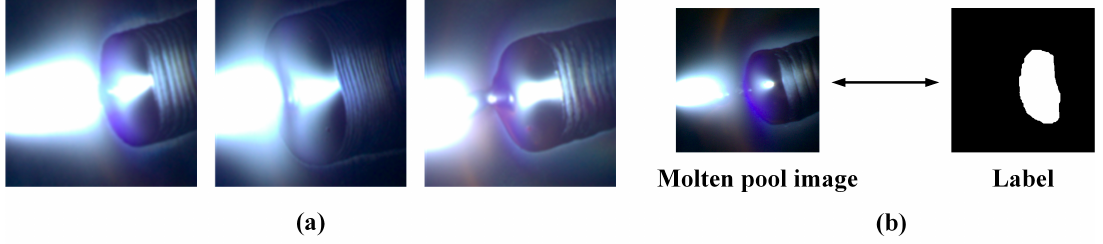
Figure 3. ( a ) Cropped molten pool images of various process parameters; ( b ) molten pool image and its corresponding label.